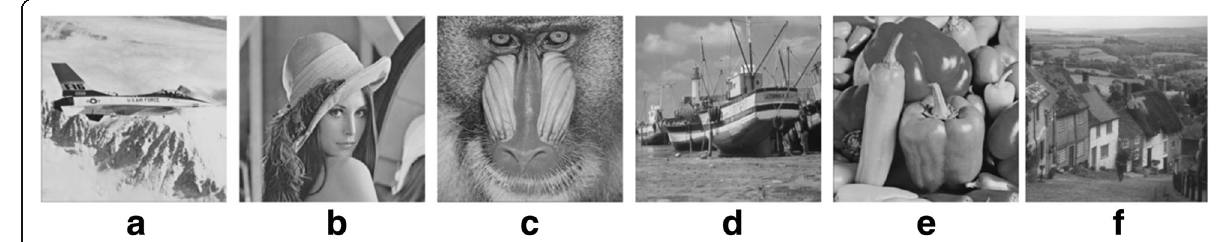
Fig. 5 Six grayscale test images: a F16 Airplane. b Lena. c Baboon. d Boat. e Pepper. f Gold